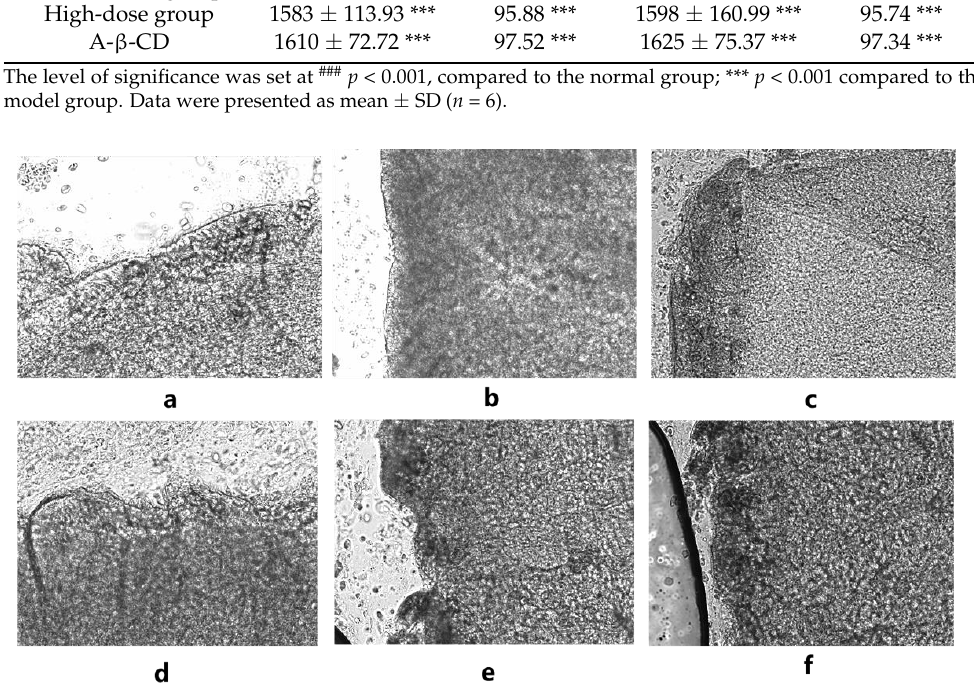
Figure 5. Optical microscope image of the upper jaw mucosa of Bufo gargarizans with a magnification of 50 × . ( a ) Normal group; ( b ) positive control group; ( c ) low-dose group; ( d ) middle-dose group; ( e ) high-dose group; ( f ) a- β -CD group.